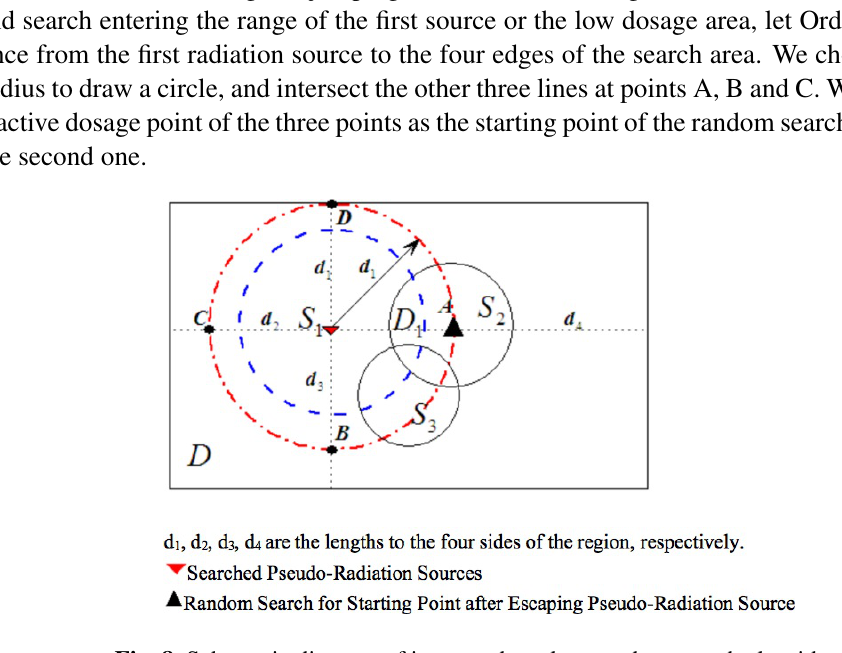
Algorithm 13: Marked Random Search Optimisation Algorithm